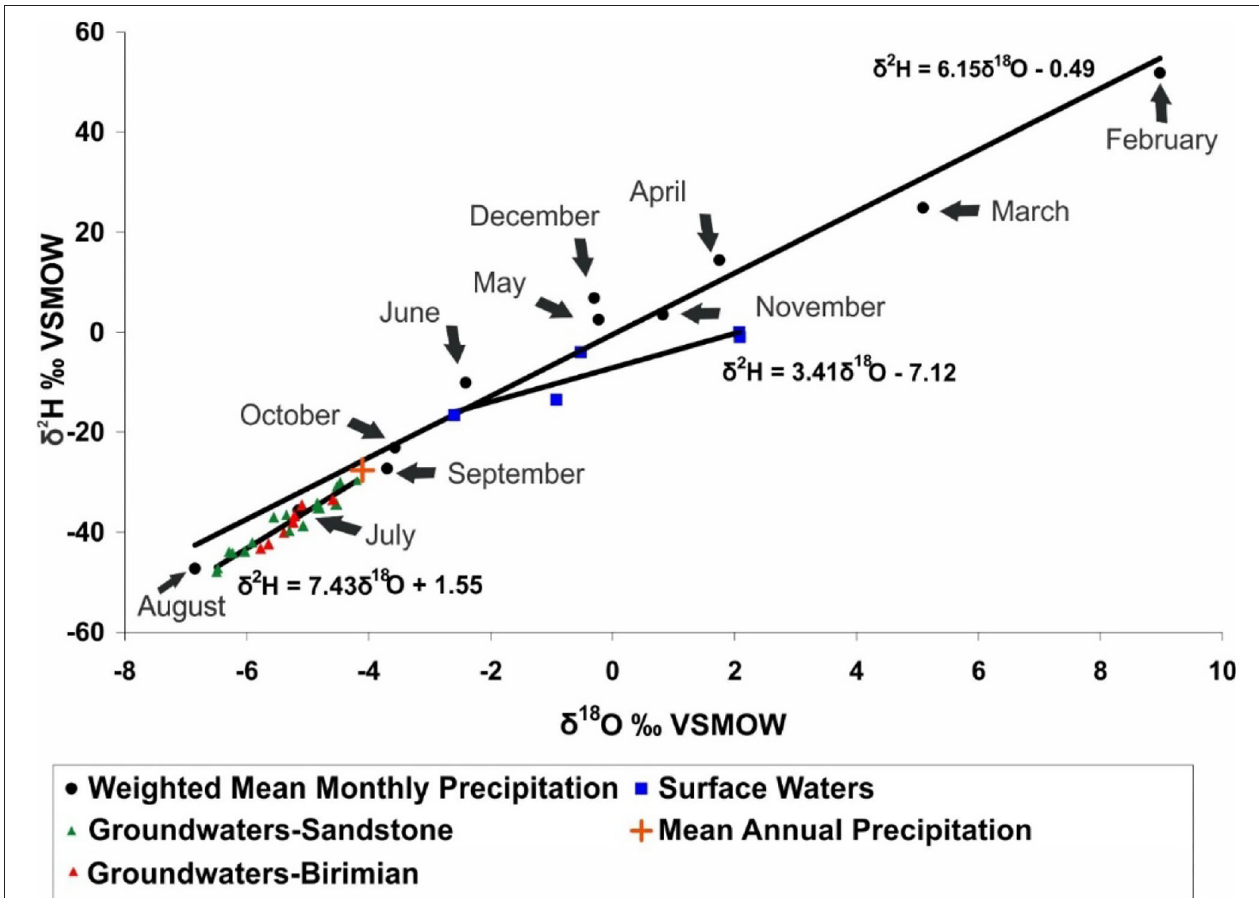
FIGURE 6 | Weighted mean monthly and mean annual δ 18 O and δ 2 H signatures of Bamako precipitation, with the δ 18 O and δ 2 H content of groundwaters in the Sandstone and Birimian, and surface waters sampled in May of